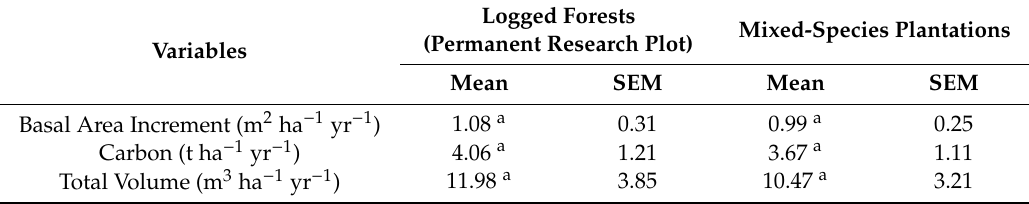
Table 5. Basal area, carbon and volume increment in logged forests (permanent research plot) and mixed-species plantations.